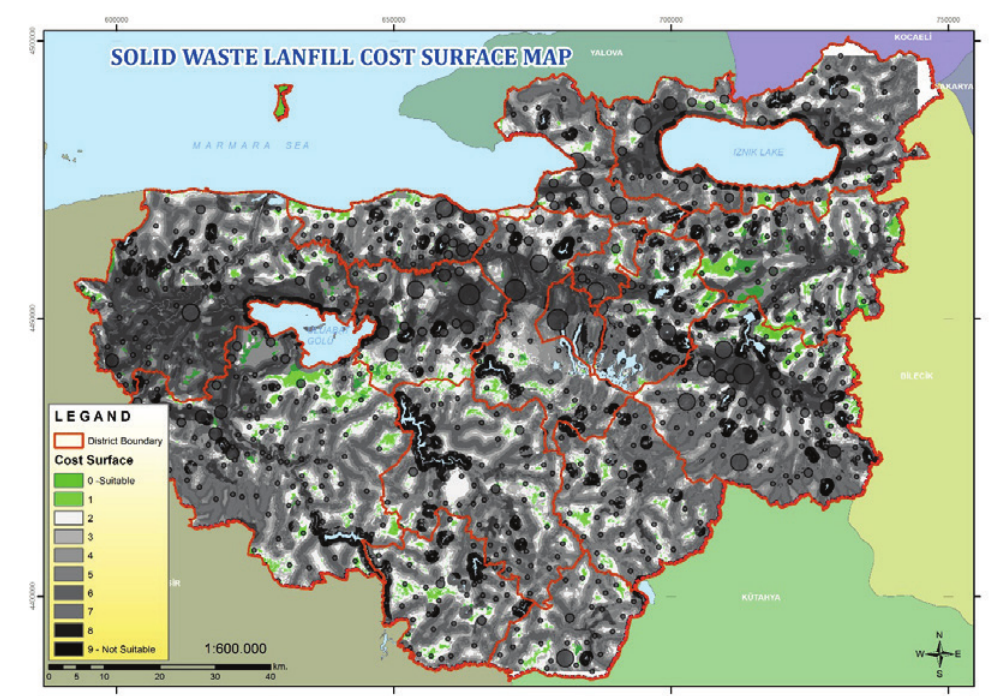
Figure 4. Bursa landfill cost surface